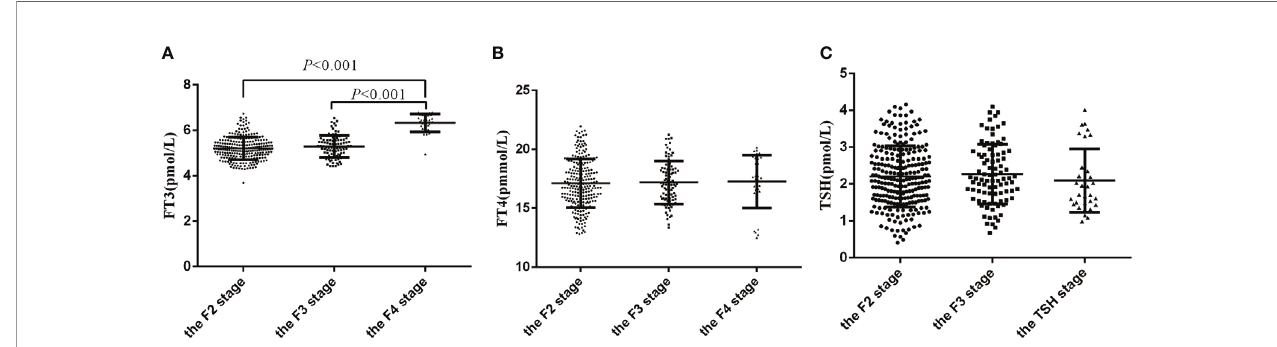
FIGURE 2 | The levels of FT3, FT4 and TSH in subjects with F2, F3 and F4 fi brosis. (A) The levels of FT3 in subjects with F2, F3 and F4 fi brosis; (B) The levels of FT4 in subjects with F2, F3 and F4 fi brosis; (C) The levels of TSH in subjects with F2, F3 and F4 fi